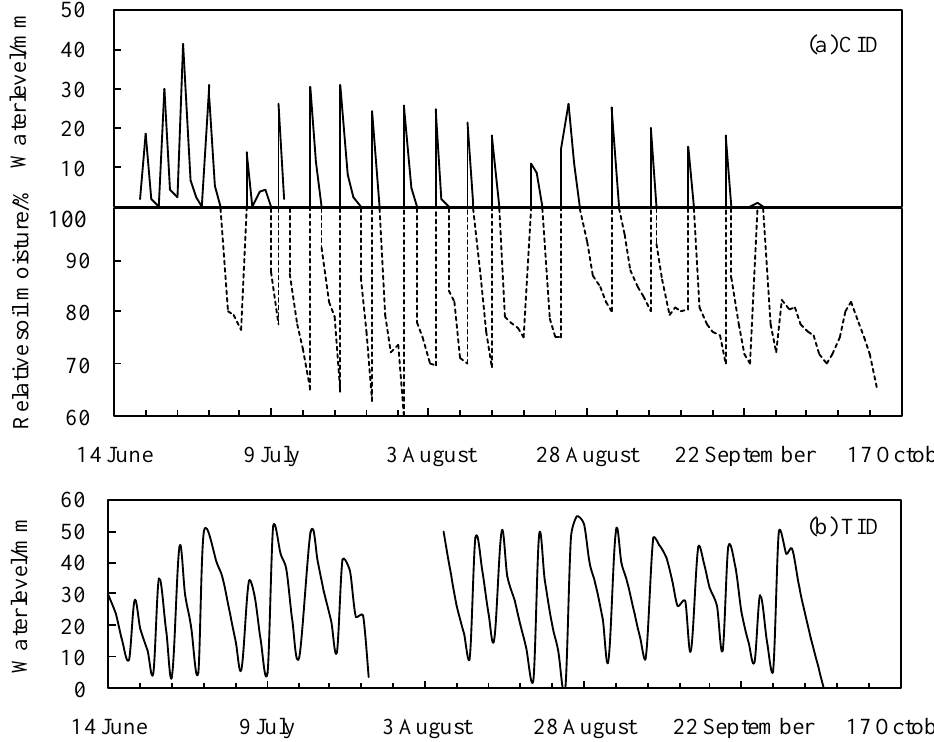
Figure 4. Typical water depth and soil moisture conditions in the controlled irrigation and drainage (CID) mode ( a ) and the traditional irrigation and drainage (TID) mode ( b ). The irrigation amounts in the CID and TID modes were 481.2 mm and 726.3 mm, respectively (Figure 5). There were 24 rainfalls during the rice growth period in the test area, and the total rainfall was 428.2 mm, including four rainstorms ( ≥ 30 mm) and seven heavy rain events (15–29.9 mm). In the CID and TID modes, the numbers of drainage were 16 and 21, respectively, and the drainage were 175.5 mm and 446.9 mm, respectively. Effective controlled drainage of paddy fields is an important way to reduce agri- mode significantly reduced drainage by 271.4 mm and60.7%. In the CID mode, drainage